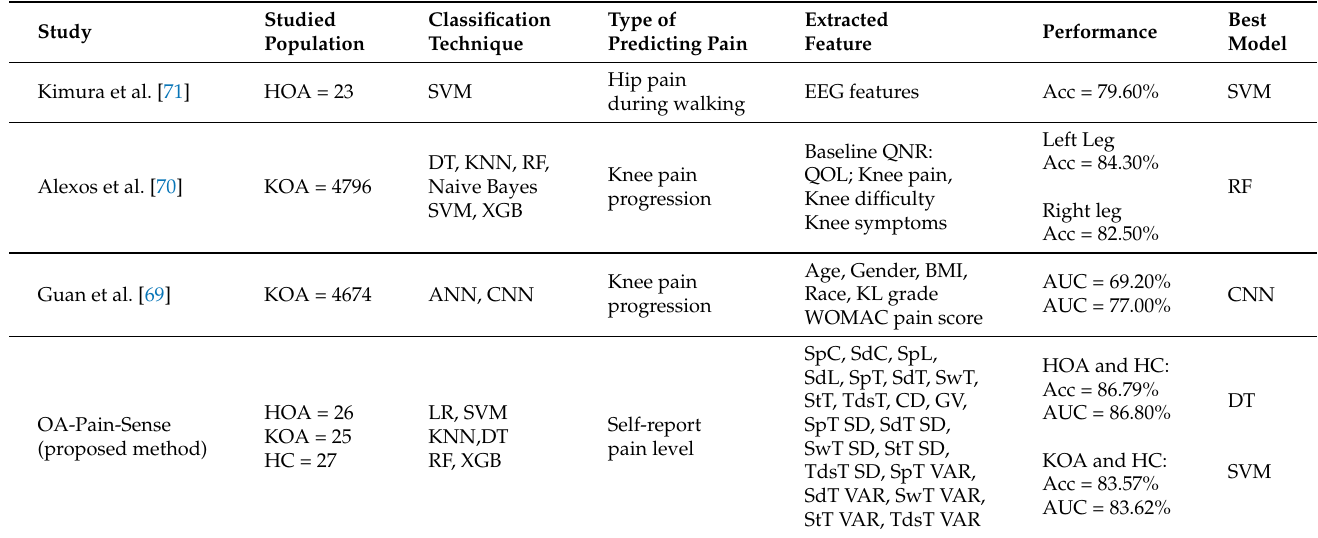
Table 11. Comparison of performance achieved by prior related